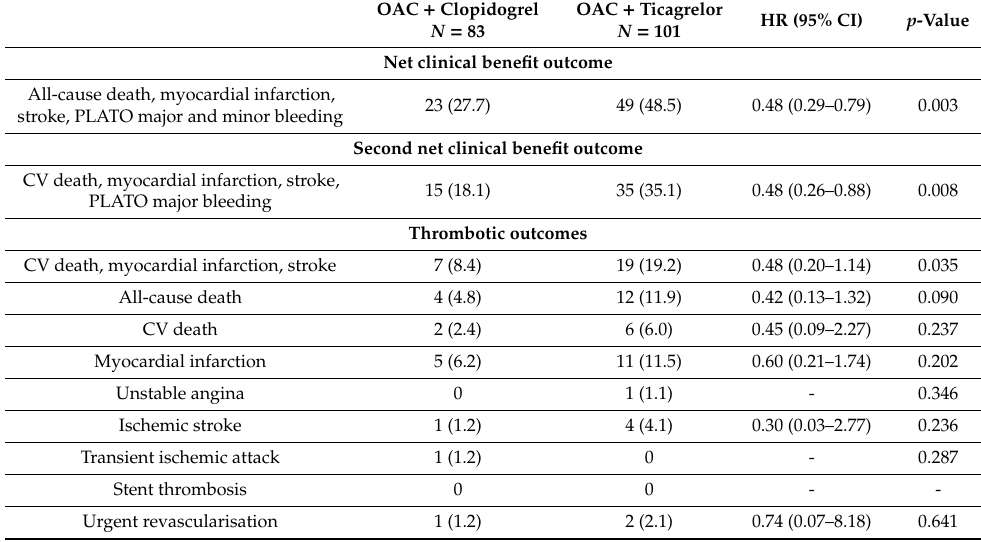
Table 4. Primary net clinical benefit outcome and secondary thrombotic outcomes at 1